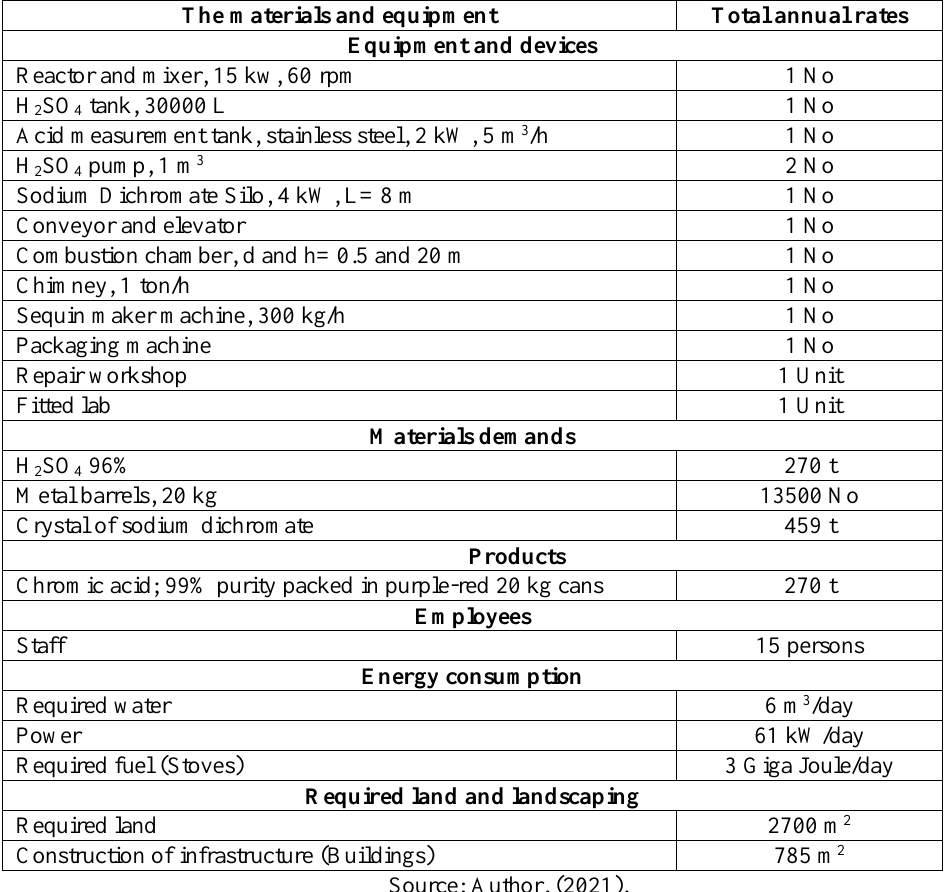
Table 4: The annual requirements of industries of chromic acid (nominal capacity of 270 tones). The materials and equipment Total annual rates Equipment and devices